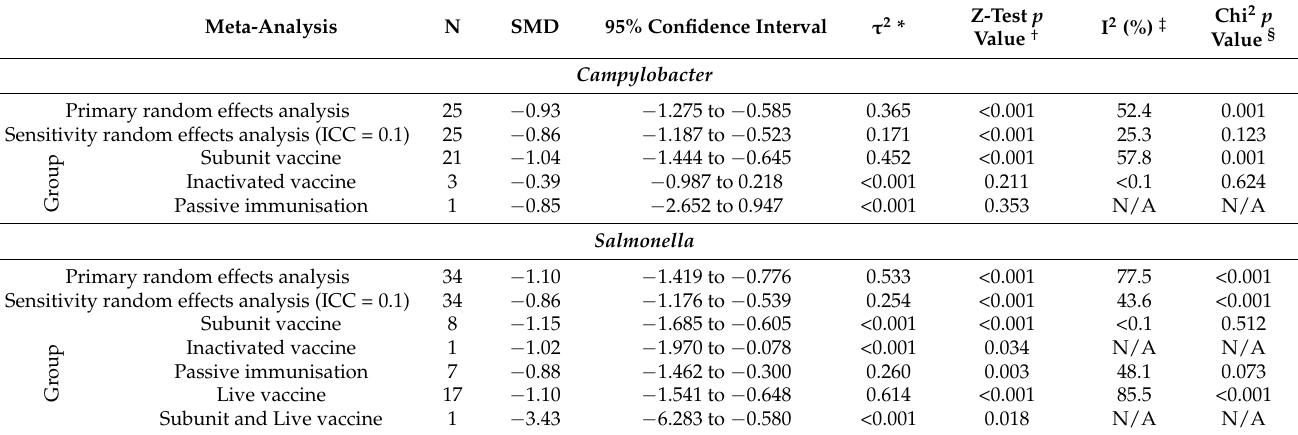
Table 4. Statistical results for random effects meta-analyses of standardised mean differences to investigate the effect of vaccinations on caecal Campylobacter and Salmonella in meat chickens. SMDs are presented to 2 decimal